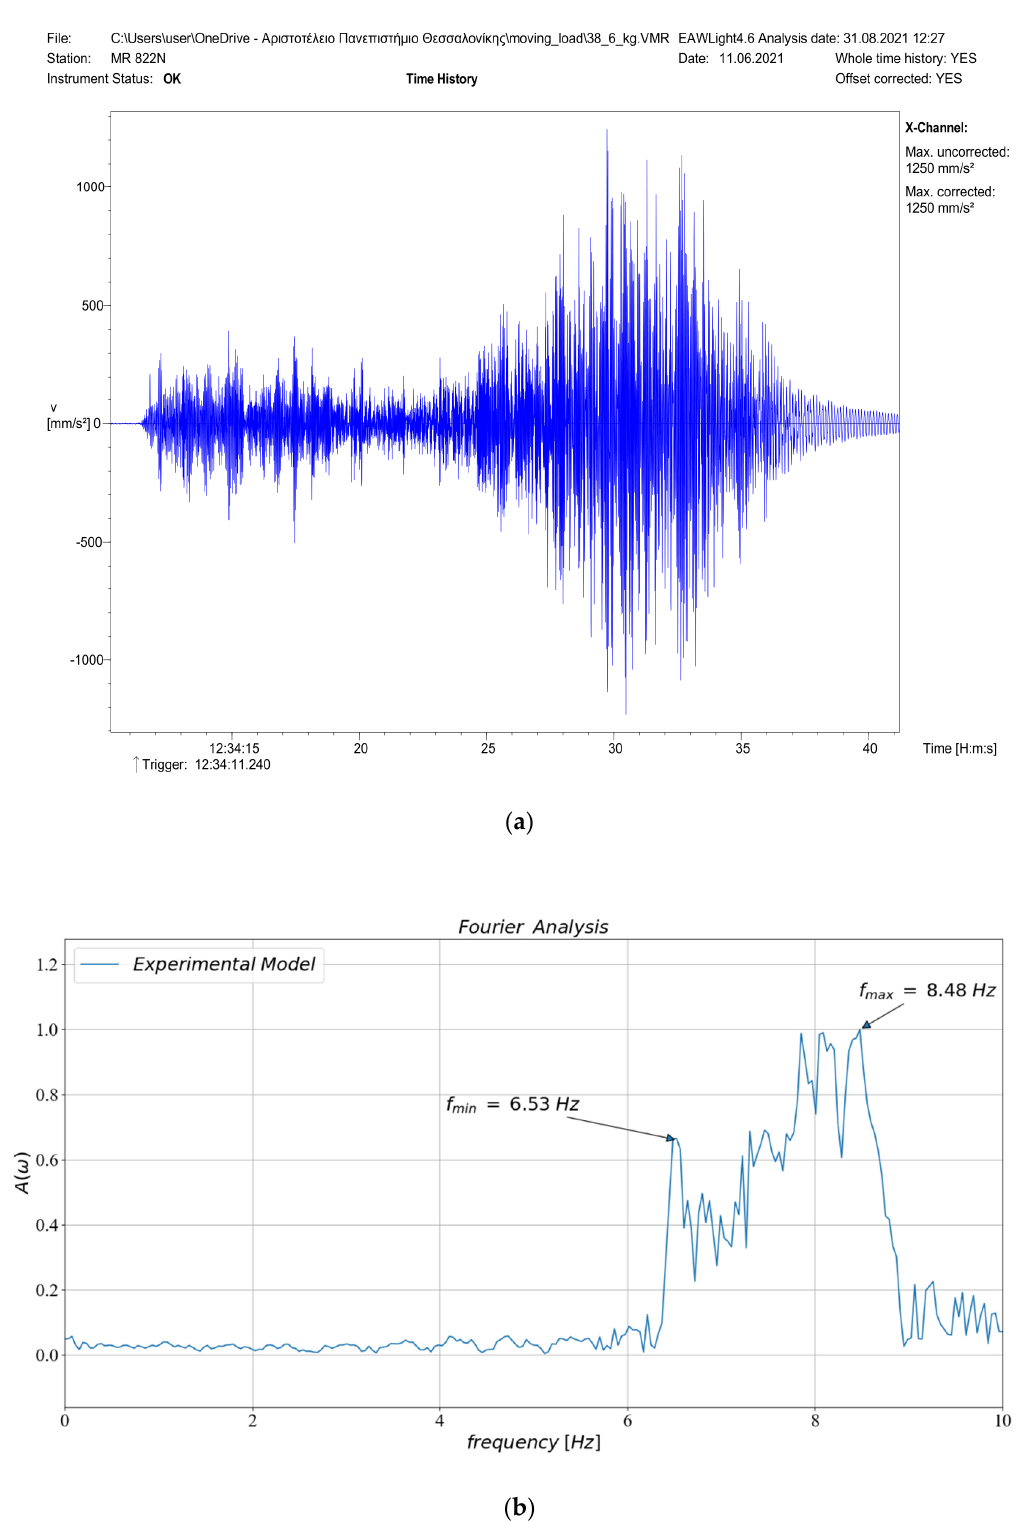
Figure 8. Measured ( a ) acceleration time history and ( b ) FFT acceleration spectrum from the experimental setup of a model bridge deck traversed by heavy mass m = 38.60 kg moving at a speed of v = 0.247 m/s.